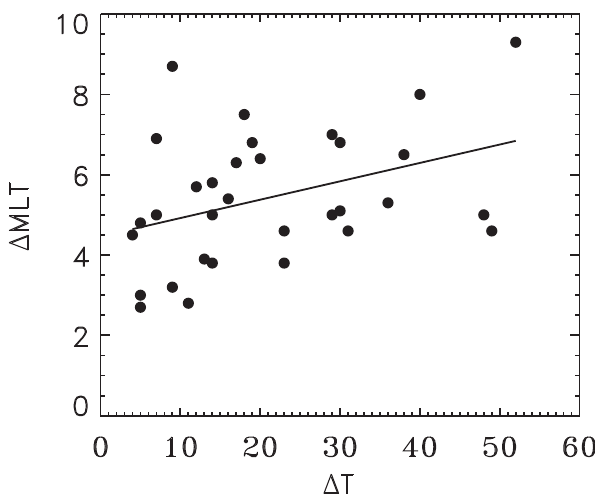
Fig. 12. Length in MLT of the type of substorms illustrated by the images labeled b, c and d in Fig. 3 as a function of development time for the substorm. Straight line is a least squares